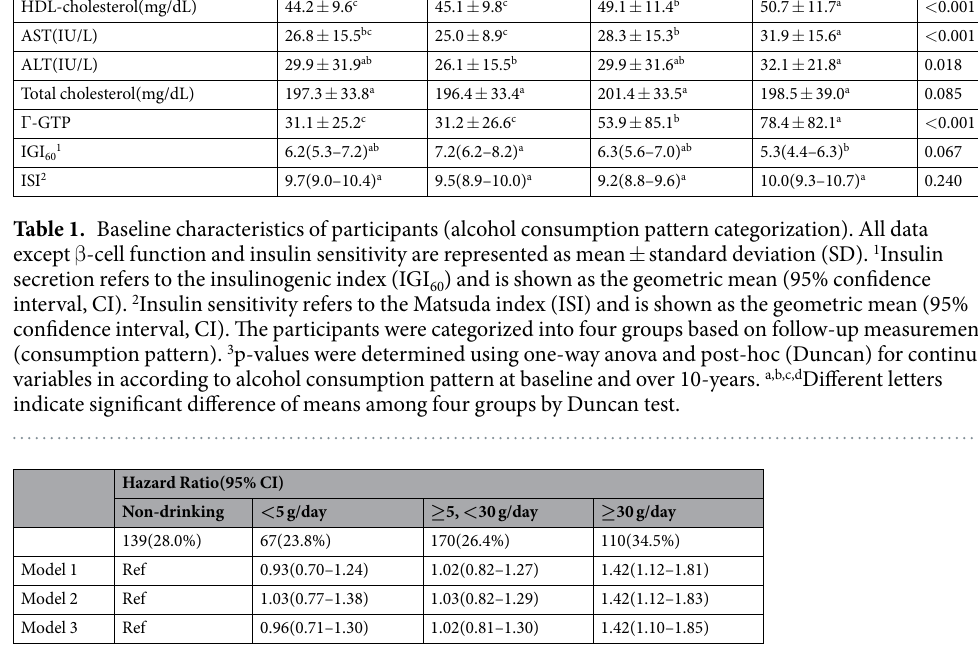
Table 2. Association between alcohol consumption at baseline and 12-year incidence of type 2 diabetes. The participants were categorized into four groups based on the baseline measurement (one-point measure). Model 1: adjusted for age and Body mass index. Model 2: adjusted for age, Body mass index, family history of diabetes, and smoking. Model 3: adjusted for age, Body mass index, family history of diabetes, smoking, physical activity, total energy intake and IGI 60